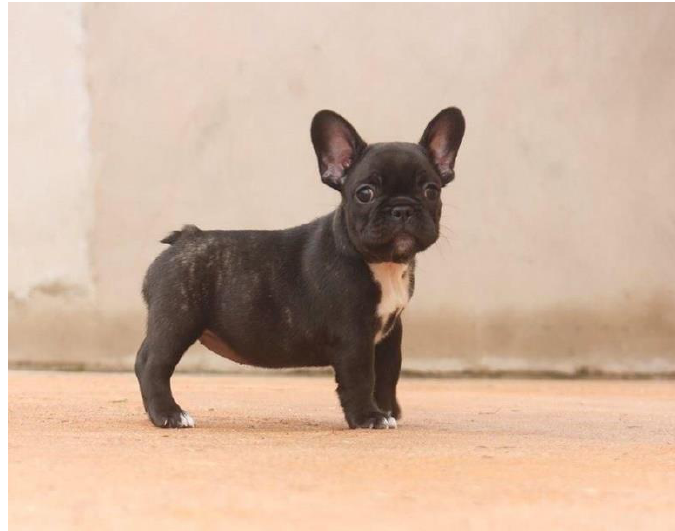
Figure 9. Puppy at two months old.